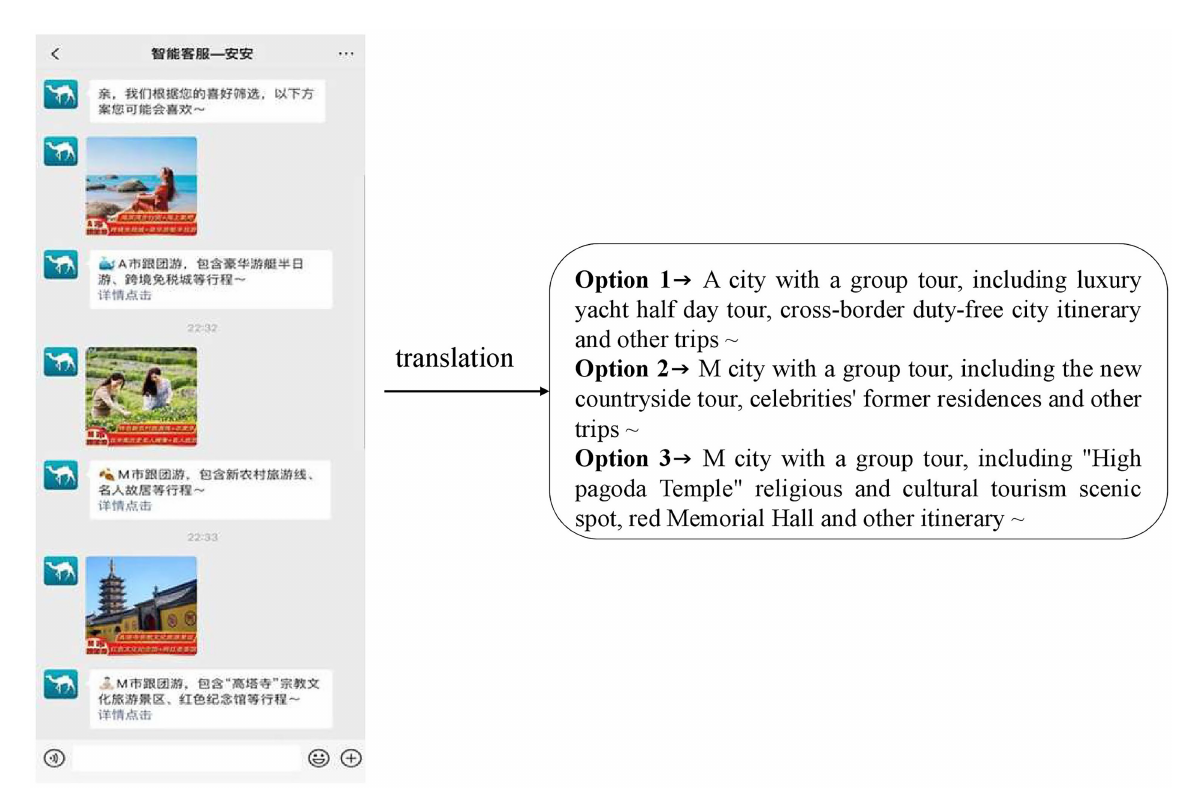
FIGURE 2 Experimental scenario of the number of recommended options 3. Images source from: m.qunar.com. Reproduced with